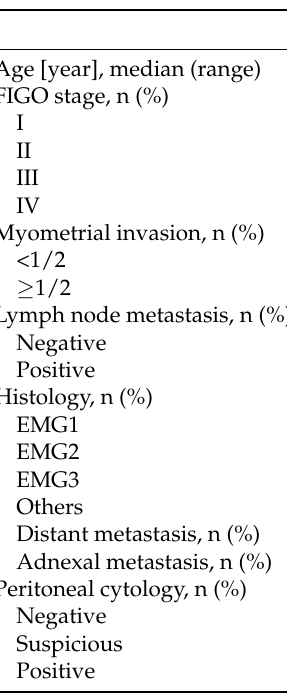
Table 1. Patient characteristics.